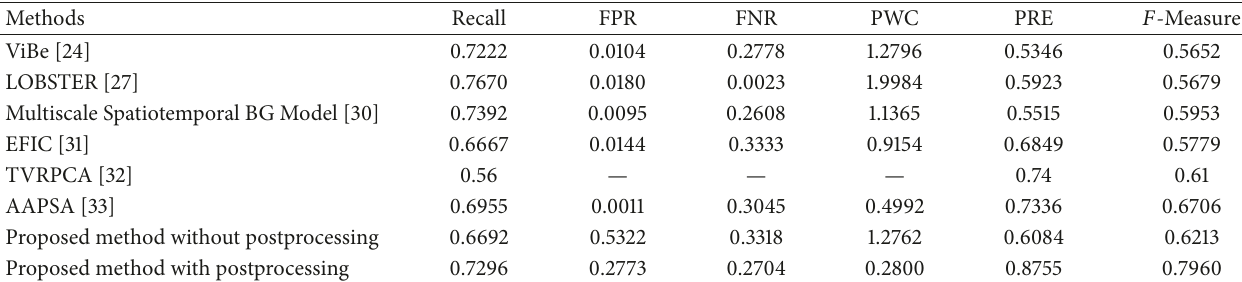
Table 3: Comparison of performance between the proposed method and